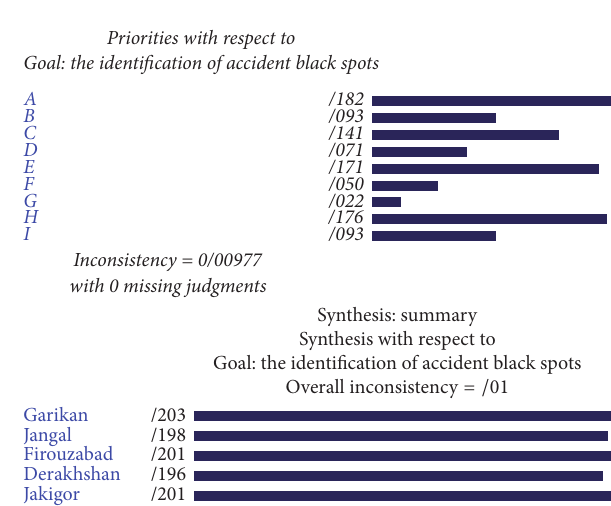
Figure 7: Section 5: Pashaamag